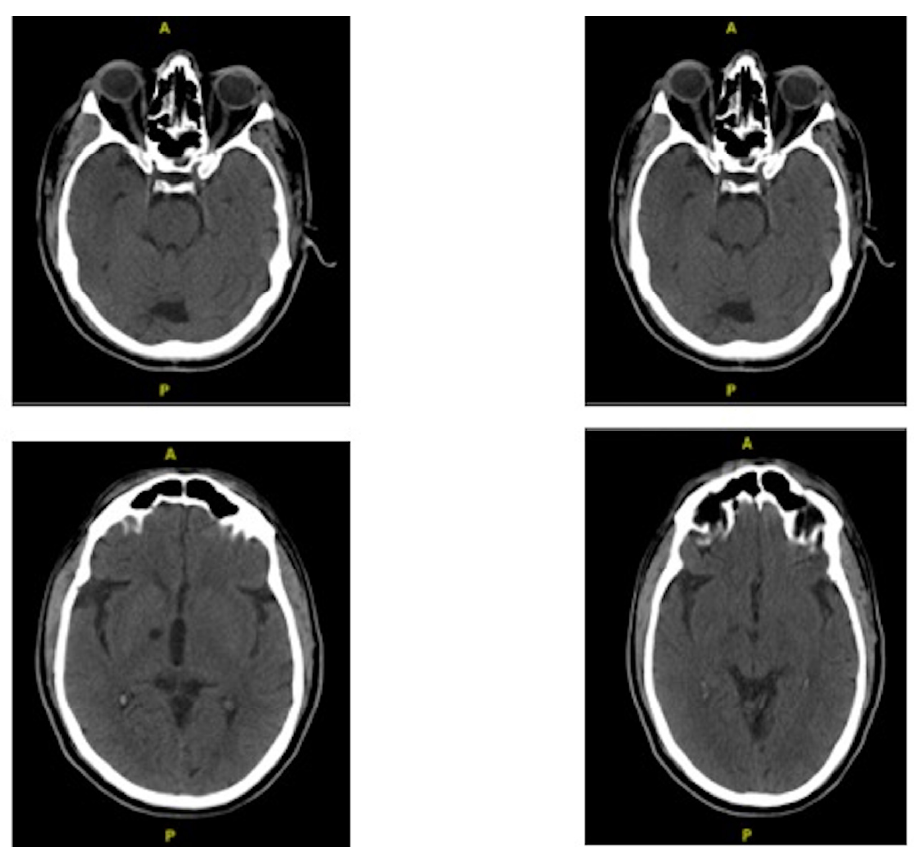
Figure 1. CT Scan results with four cuts in axial view.